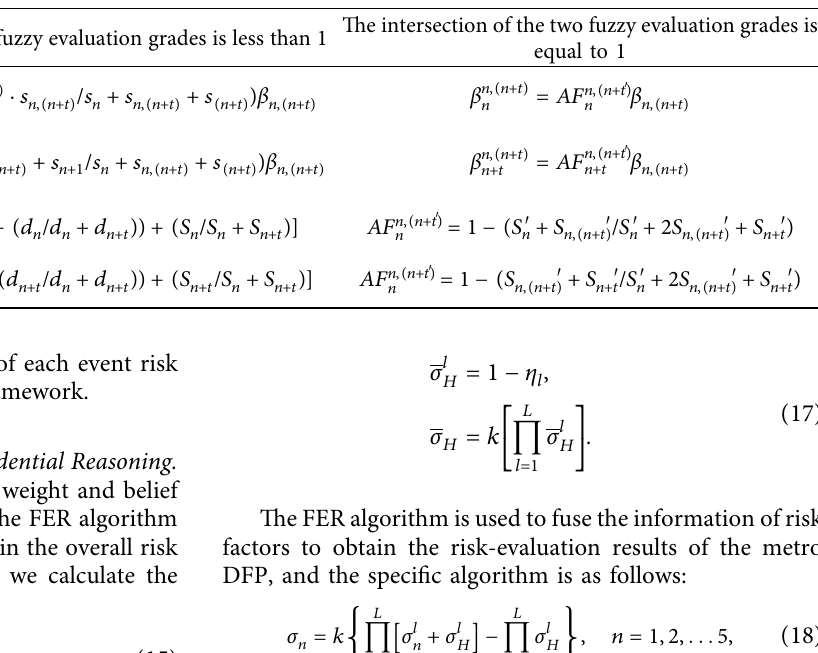
Figure 2: Intersection of different fuzzy grades. Table 8: Formulas related to belief